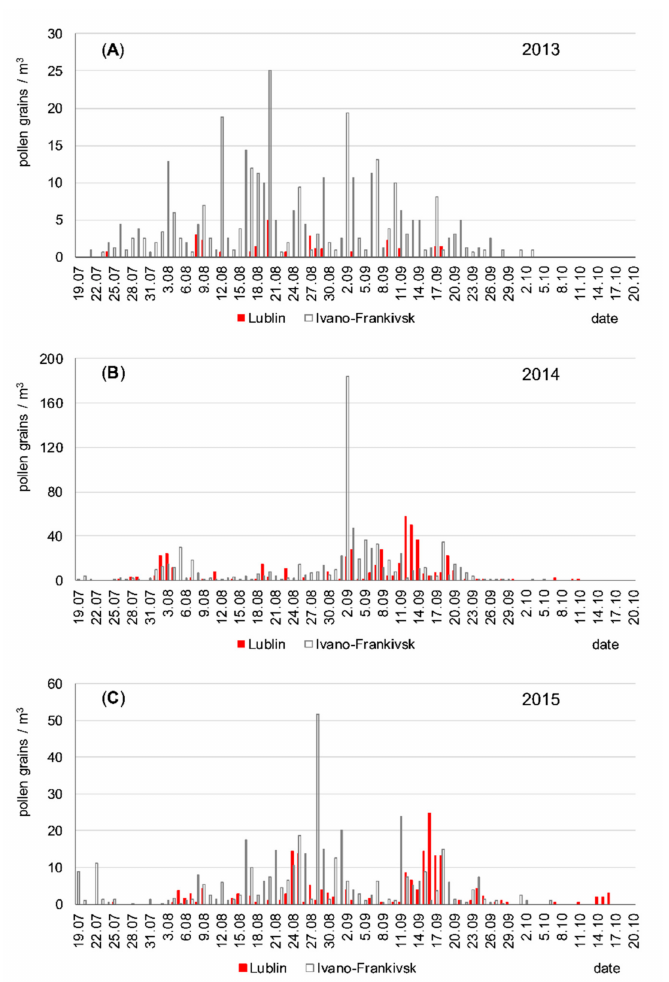
Figure 2. Comparison of Ambrosia pollen seasons in Lublin and Ivano-Frankivsk in ( A ) 2013; ( B ) 2014; ( C ) 2015.